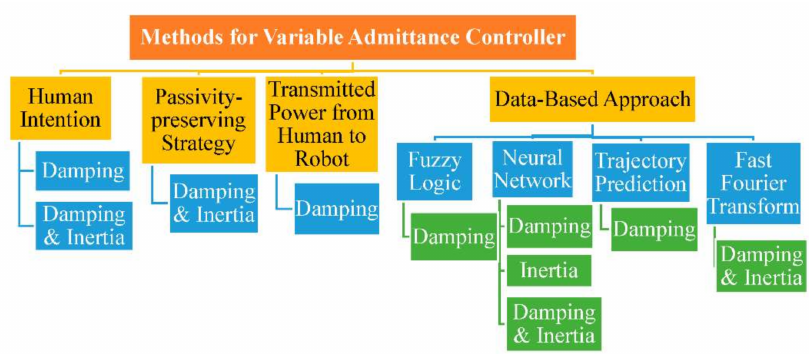
Figure 4. The classifications of the used techniques for developing VA control whether adjusting the damping only, the inertia only, or both the damping and